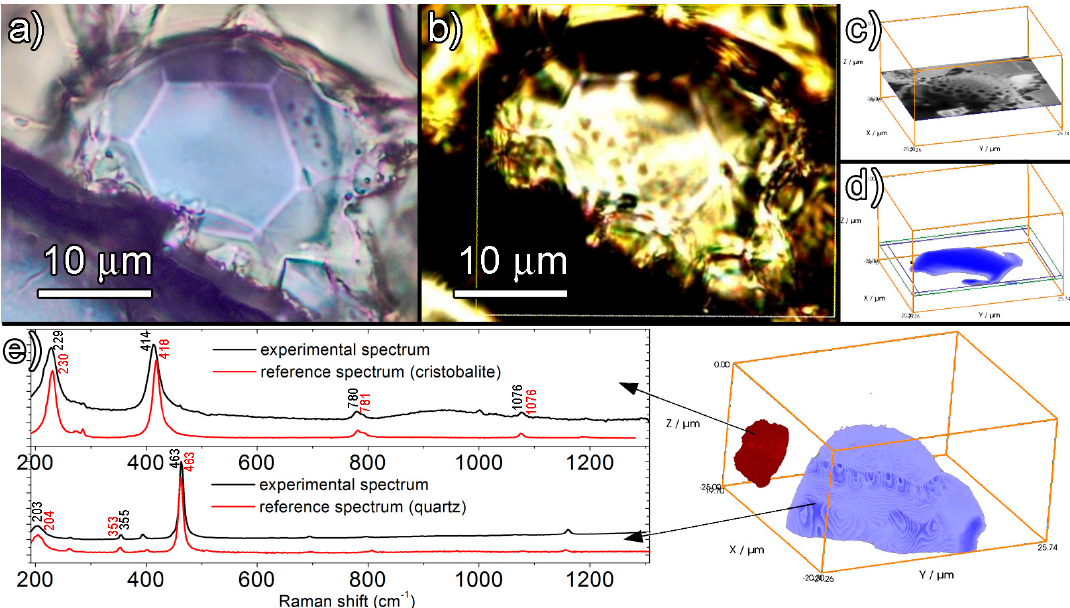
Figure 9. ( a ) A photomicrograph of crystallite exhibiting a distinguishable hexagonal face (TL). ( b ) The same image as Figure 9a taken from the microscope coupled to the inVia Qontor Raman system. ( c ) A focused optical image of one of the layers within the inspected volume. ( d ) The compositional mapping of the presence of quartz (blue) on the layer seen in Figure 9c. ( e ) A 3-D mapping of quartz (blue) and cristobalite (red) within the inspected volume along with two Raman spectra from the volume showing the agreement between the measured spectra and the reference spectra for quartz and cristobalite. The measurements were performed using a ×100 objective with a numerical aperture of 0.85 and a laser wavelength of 532 nm that provides a vertical resolution of around 1 μ m.